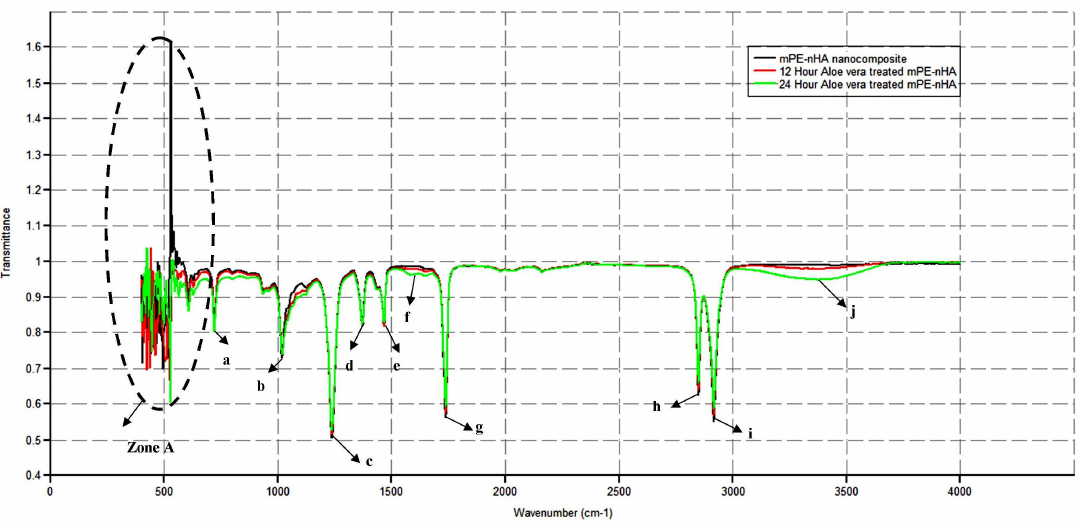
Figure 3. A representative FTIR spectra of pristine mPE ‐ nHA, 12 and 24 h Aloe vera dip ‐ coated mPE ‐ nHA nanocomposites. ( a ) 714 cm − 1 , ( b ) 1014 cm − 1 , ( c ) 1232 cm − 1 , ( d ) 1369 cm − 1 , ( e ) 1469 cm − 1 , ( f ) 1583 cm − 1 , ( g ) 1731 cm − 1 , ( h ) 2845 cm − 1 , ( i ) 2912 cm − 1 , ( j ) 3363 cm − 1 .